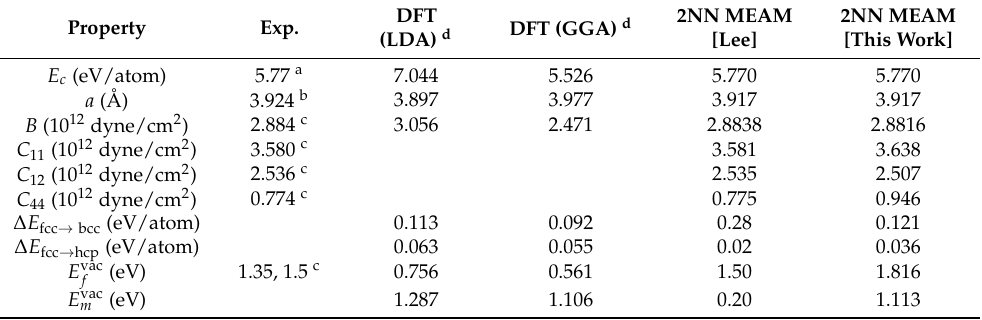
Table 3. Physical properties and various energies of pure Pt obtained from the experiment, present DFT calculations (LDA, and GGA), and previous [69] and present 2NN MEAM interatomic potentials. Cohesive energy ( E c ), lattice parameter ( a ), bulk modulus ( B ), elastic constants ( C 11 , C 12 , and C 44 ), difference in structural energy ( ∆ E ), energy of vacancy formation ( E vac ), energy of vacancy migration f ( E vac m ), activation energy of vacancy diffusion ( Q vac ), and surface energy ( E surf ) are compared. The respective units are provided in the